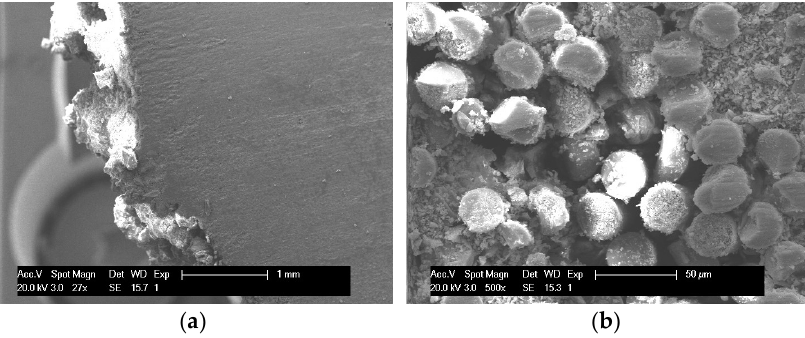
Figure 10. Microstructure of unconditioned G2: ( a ) 27 × G2; ( b ) 500 × G2.